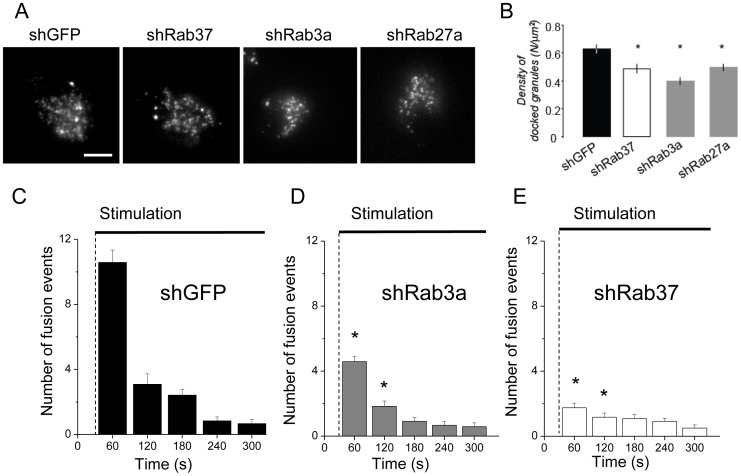
Rab37 participates in docking of insulin-containing granules.
A. Representative TIRF images showing docked NPY-mRFP containing granules in MIN6B1 cells transfected either with control shGFP, shRBa3a, shRab27a or with shRab37 (2). B. Analysis of the docked granules detected by TIRF illumination in the experiments shown in A. Histograms show the quantification of the number of docked granules per surface (µm2). Results are means ± SEM (shGFP, n = 41 cells; shRab37 (2), n = 38 cells; shRab3a, n = 33 cells; shRab27, n = 37 cells). * p<0.05 one-way ANOVA test. C. Quantification of the exocytotic events from NPY-mRFP transfected MIN6B1 cells expressing control shGFP, shRab3a or shRab37 (2). Exocytosis was triggered when indicated (Stimulation) by treating the cells with glucose, Forskolin and IBMX. Histograms represent the number of fusion events counted every 60 s (n = 12). The results shown are the means ± SEM. p * <0.05 unpaired t-test.